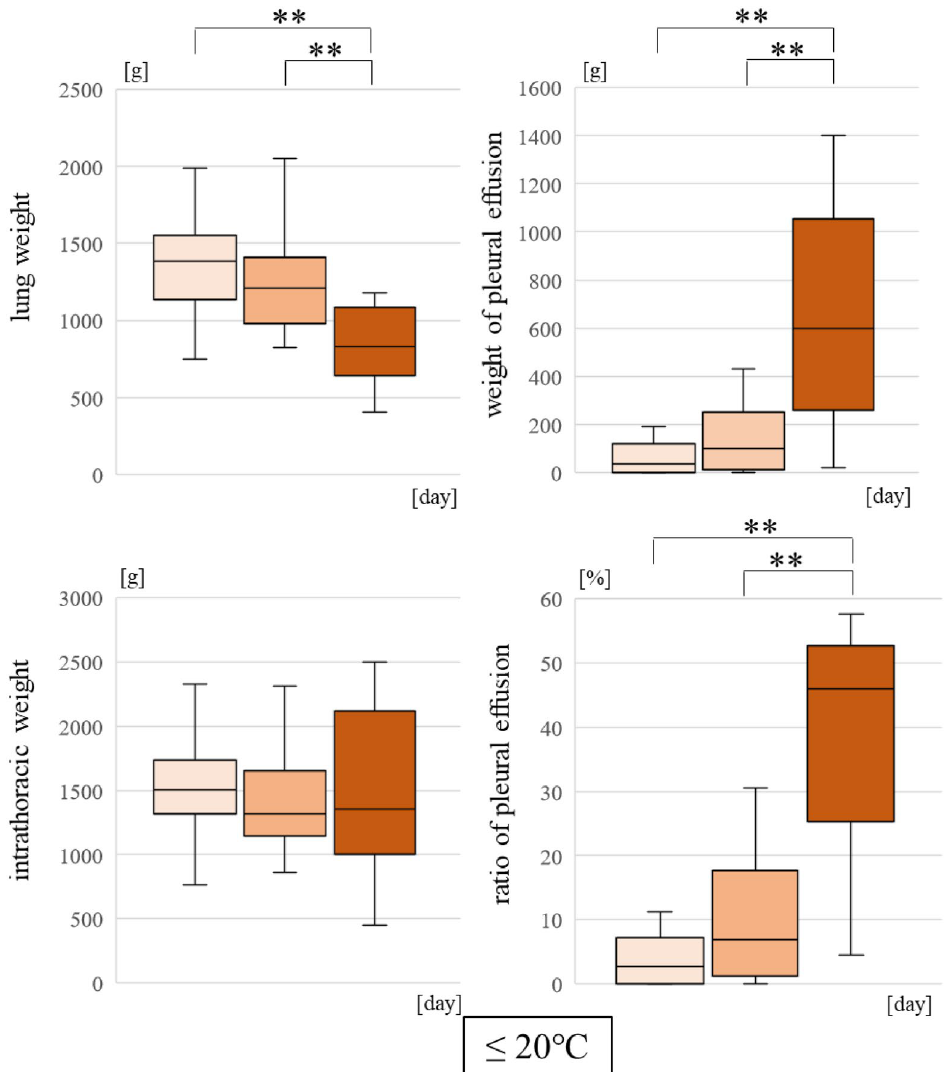
Figure 5. Comparing the parameters for different postmortem intervals in the lower water temperature group.